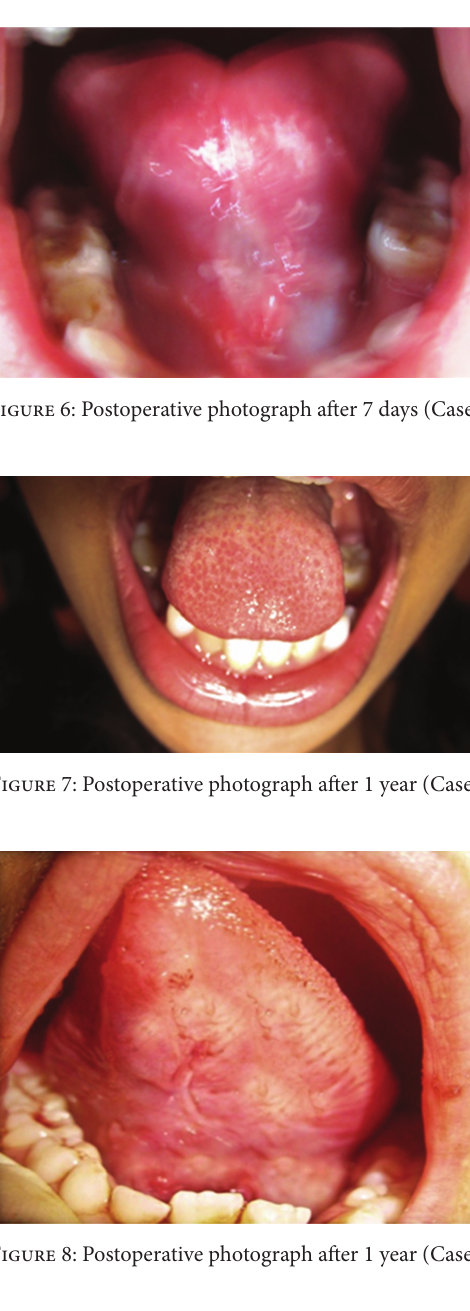
F 5: Postoperative photograph aer 7 days (Case 2).